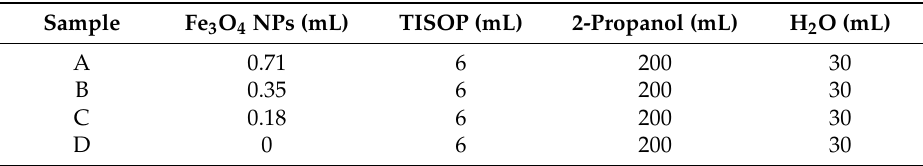
Table 2. Reagents ratios ( v / v ) for the different